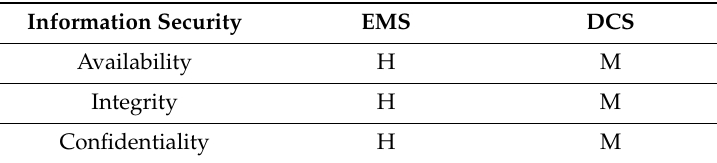
Table 5. Information security risk by SG component.